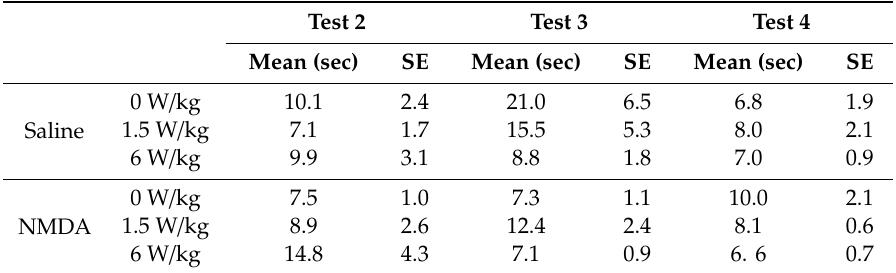
Table 1. Latencies (sec) to escape from the hot plate in the second, third and fourth tests. Sham-exposed and RF-EMF-exposed groups were tested in the two temperatures choice following i.t. saline or NMDA injections. There was no BASAR, NMDA or restraint e ff ect. N = 6–12 rats / group.